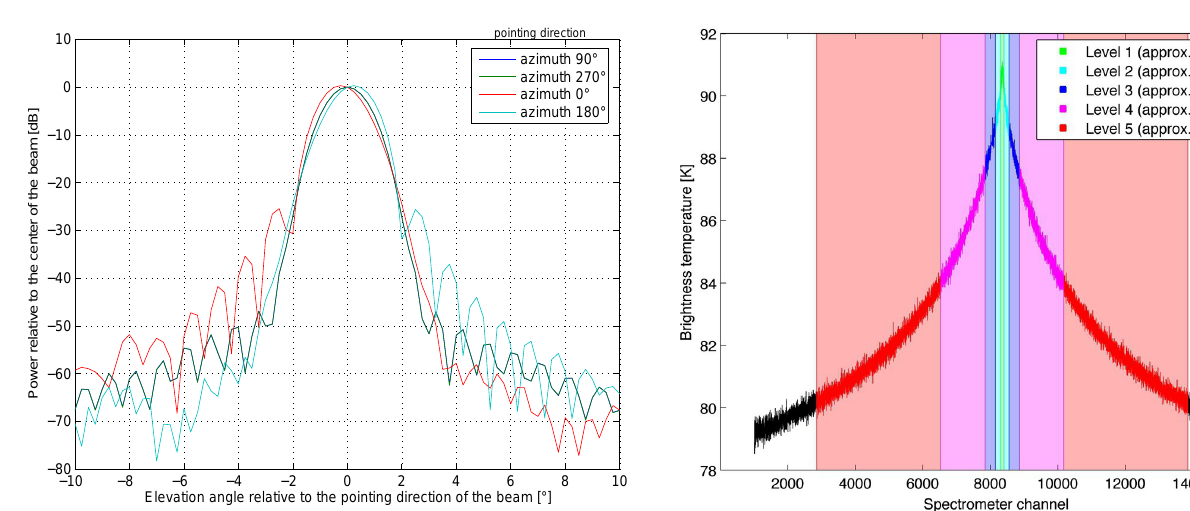
Fig. 7. Illustration of the choices of spectrometer channels A used in our standard wind retrieval. The spectrum plotted in black is the ozone emission spectrum at 142GHz measured by WIRA in west- ward direction on 7 February 2011 with an integration time of one day. The shaded areas of each colour correspond to the channels contained in A for the altitude level indicated in the